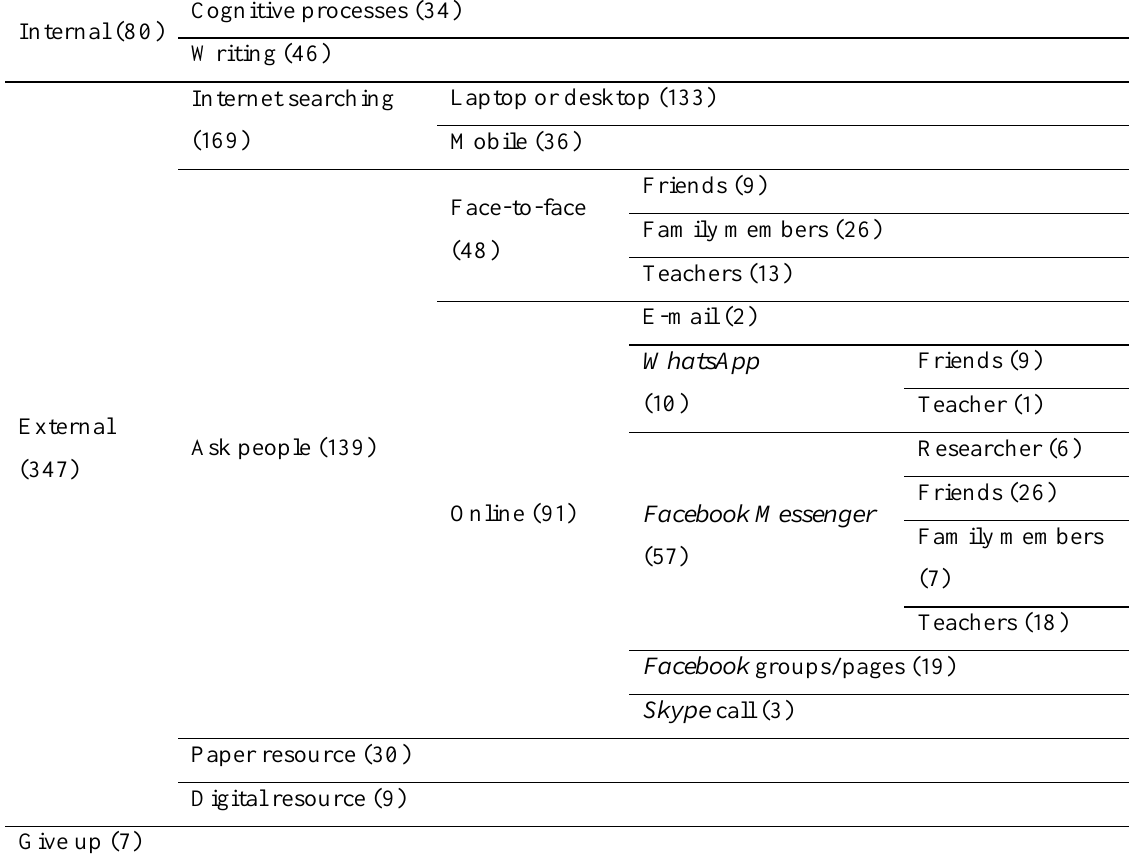
Table 2 Nodes’ Distribution (Times of